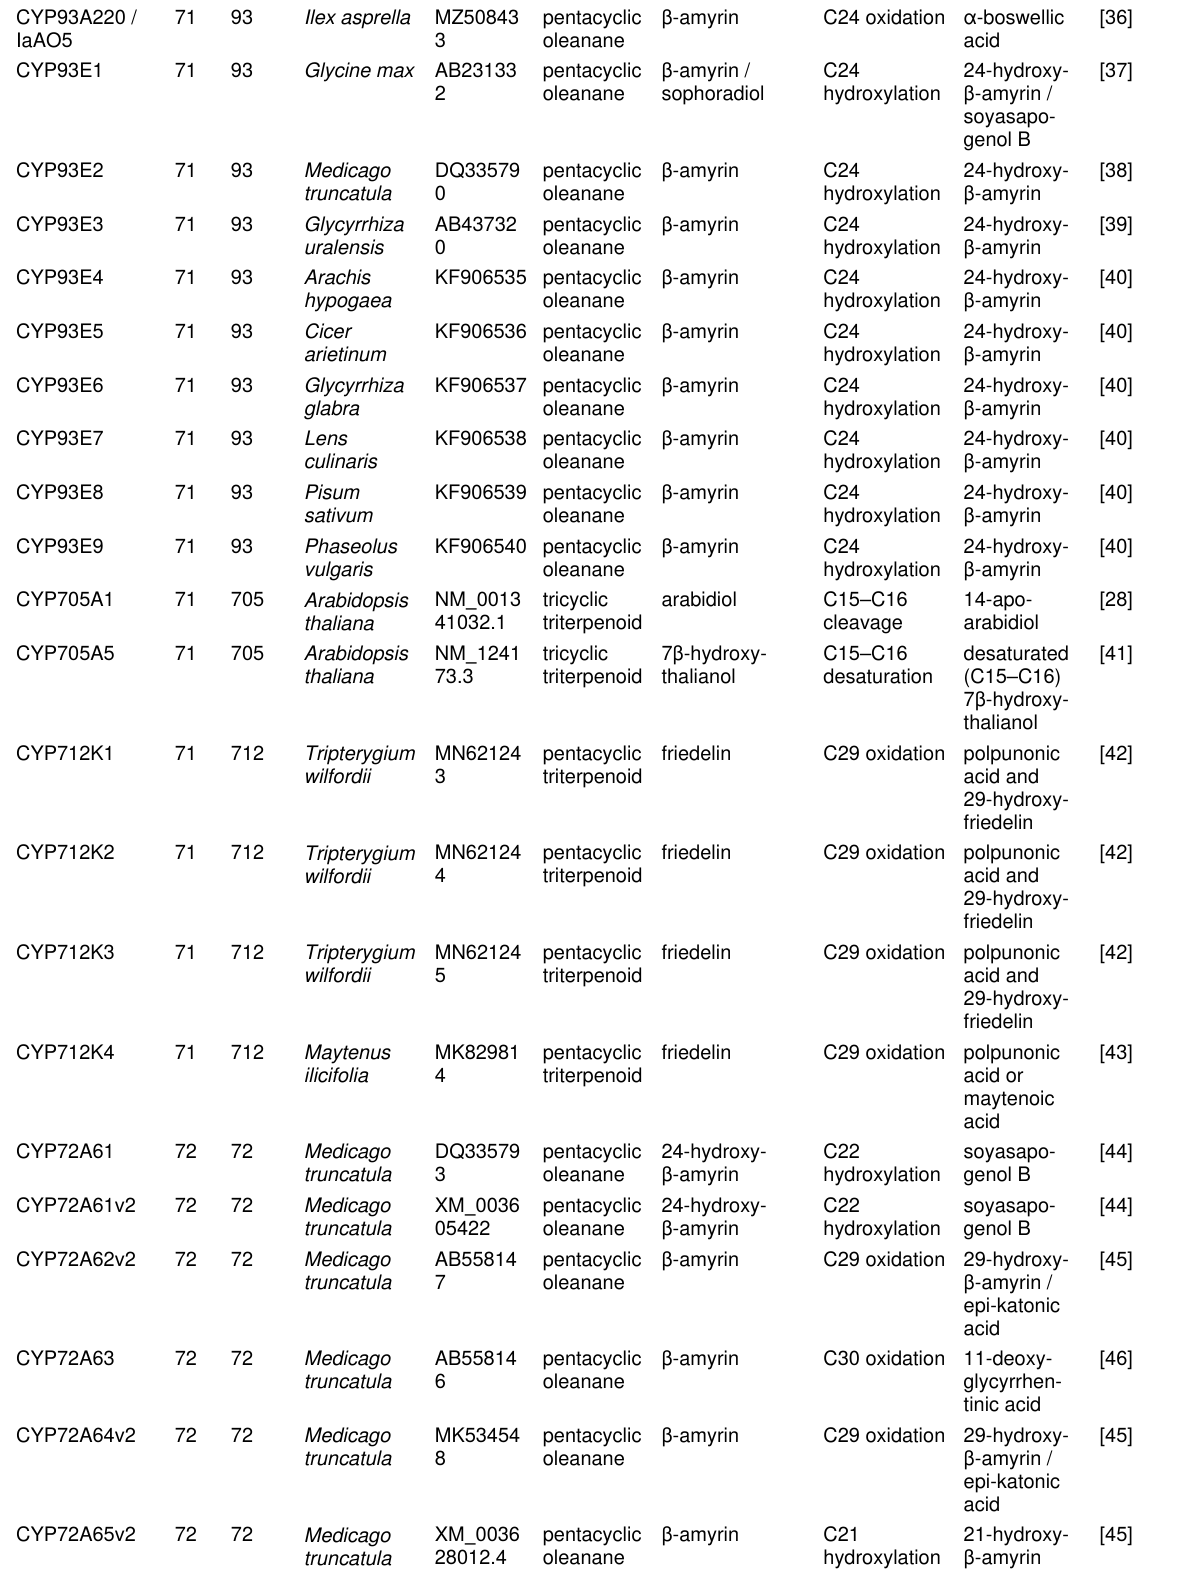
Table 1: List of characterised plant cytochrome P450 monooxygenases (CYPs) modifying triterpenoids or steroids. (continued) CYP93A220 /